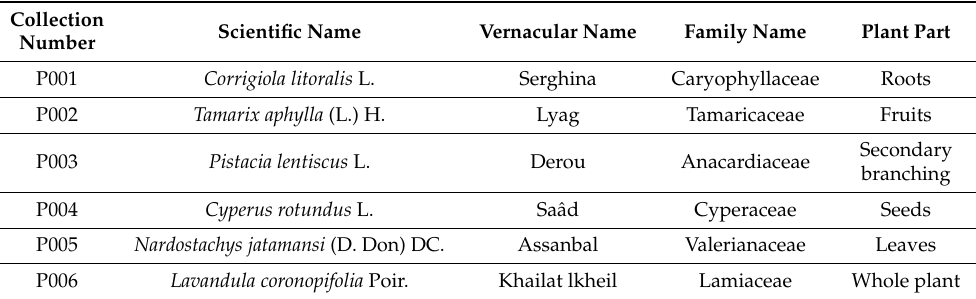
Table 3. Description of collected plant species investigated in this